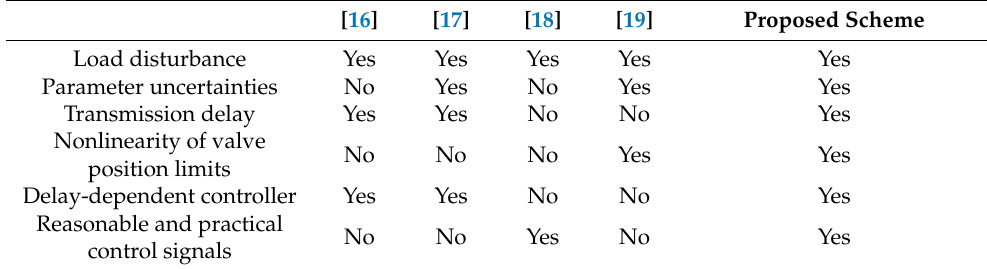
Table 4. Comparing the proposed approach with other existed works.